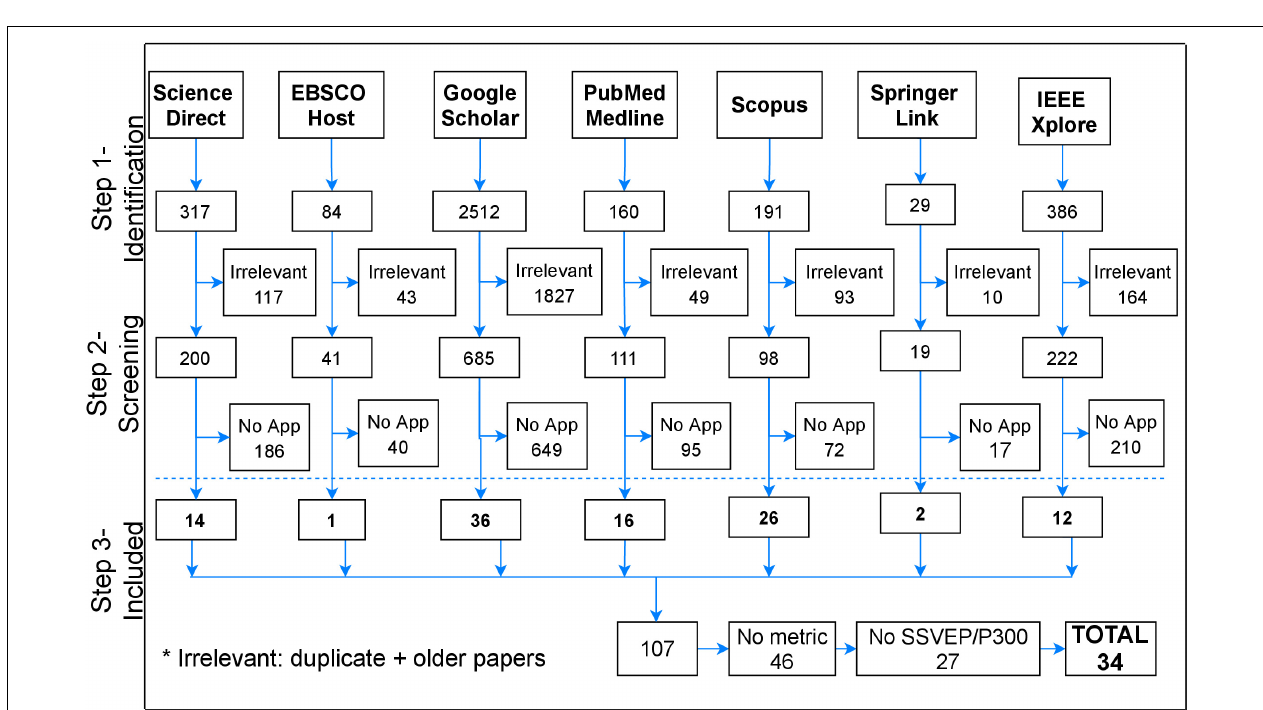
FIGURE 2 | Taxonomy of the SLR: AI methods used in BCI-based P300/SSVEP systems for motor rehabilitation applications.